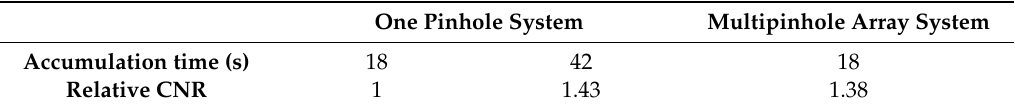
Table 3. Calculated experiment results—relative contrast to noise ratio (CNR): Systems’ relative CNR of the coin experiment. Improvement in CNR is achieved enabling to shorten the time by